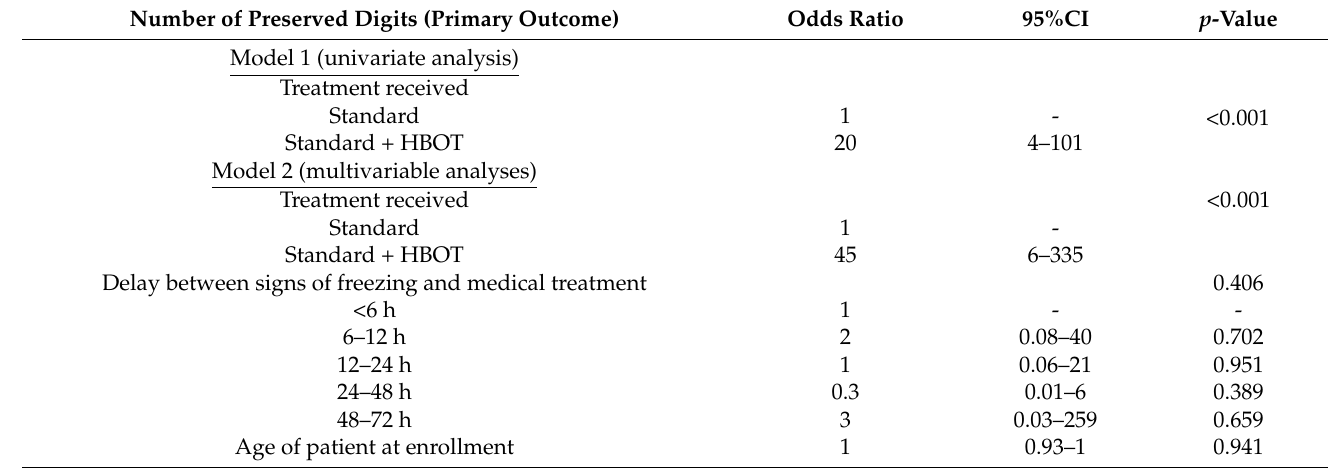
Table 3. Association between treatment group and study outcome, univariate and multivariate analyses. Number of Preserved Digits (Primary Outcome) Odds Ratio 95%CI p -Value Model 1 (univariate